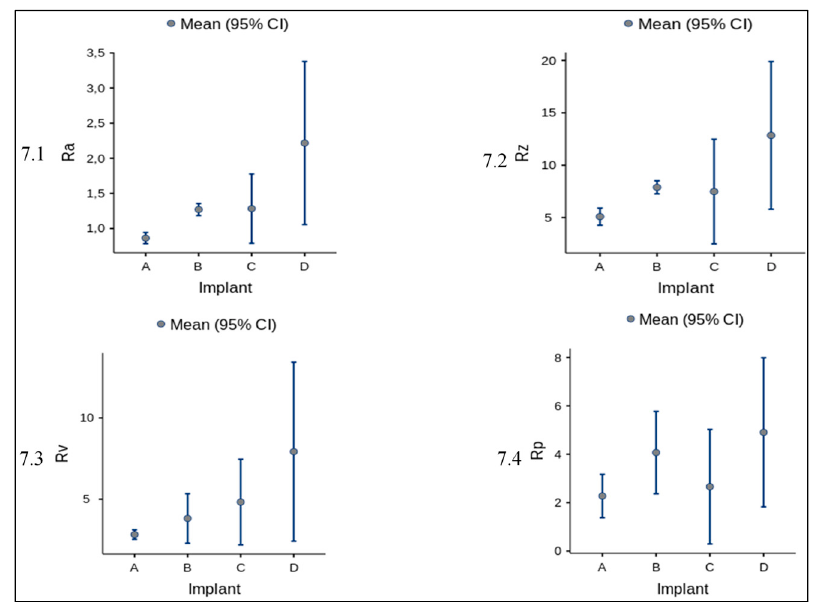
Figure 7. Mean and standard deviation of amplitude parameters for each implant. In figure are graphically represented the values reported in Table 4.